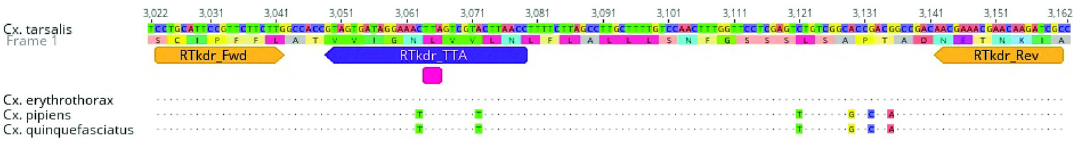
Fig 1. Culex RT kdr assay design and alignments. Sequence alignment of Cx . tarsalis (MW176090), Cx . erythrothorax (MW176091), Cx . pipiens (KY171978) and Cx . quinquefasciatus (EU817517) with Cx . tarsalis (MW176090) as the reference sequence at the kdr locus. RT kdr primers and probe are depicted in orange and purple, respectively. Disagreements to the consensus sequence are highlighted while agreements are noted as a